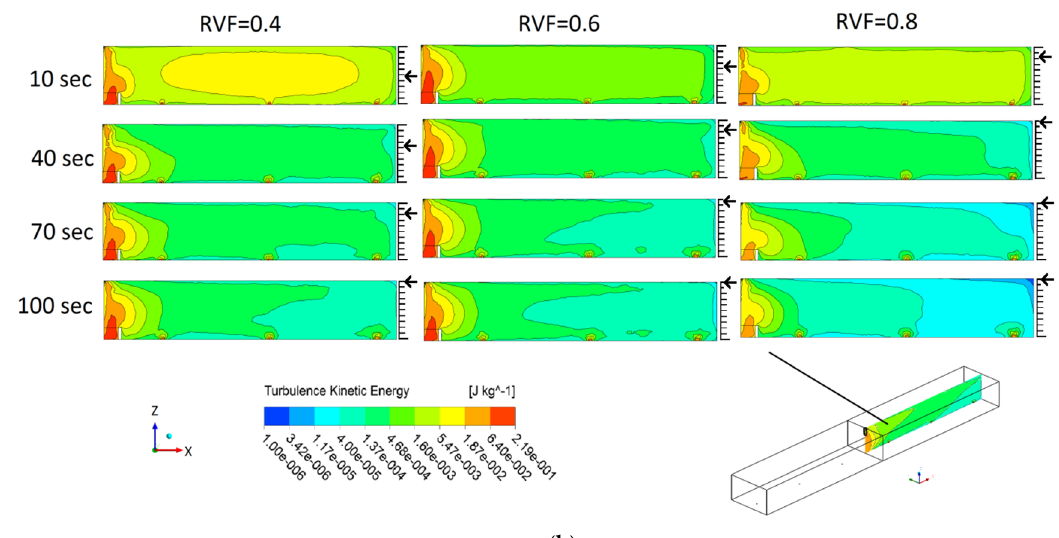
Figure 5. Contours of turbulent kinetic energy on middle plane of ( a ) bare tundish, and ( b ) tundish with APB. (The value 0 and 1 depicts old and new grade, respectively).